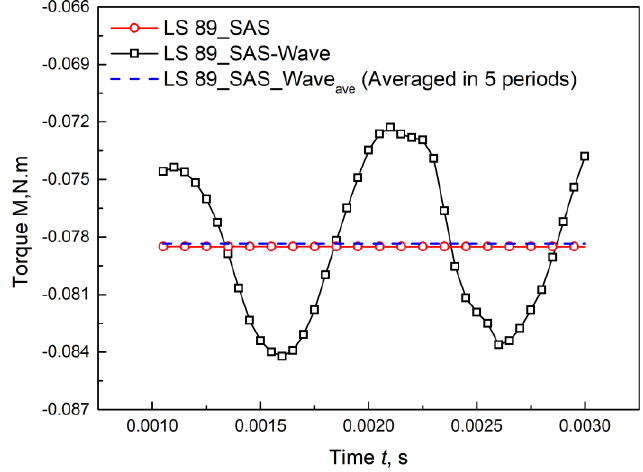
Figure 8. Influence of the entropy wave on the torque on the vane.